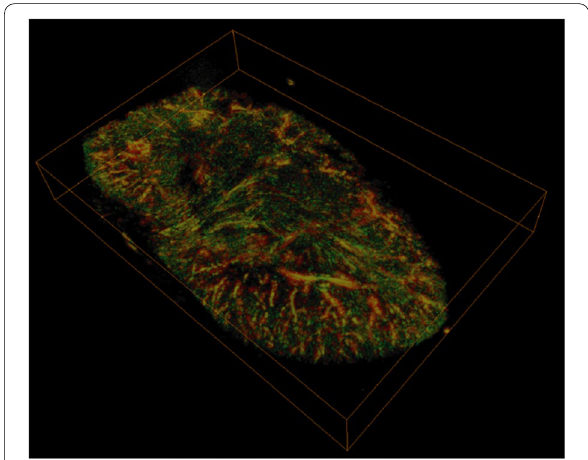
Fig. 2 3D Visualization of an entire organ. 3D visualization of an entire kidney. Merged frequencies (red lower frequencies, = bigger vessels; green higher frequencies, smaller vessels) provide = information about the position of the partially overlapping big and small vessels and the signal strength of the different emitted signals by the amount of blood from different vessel